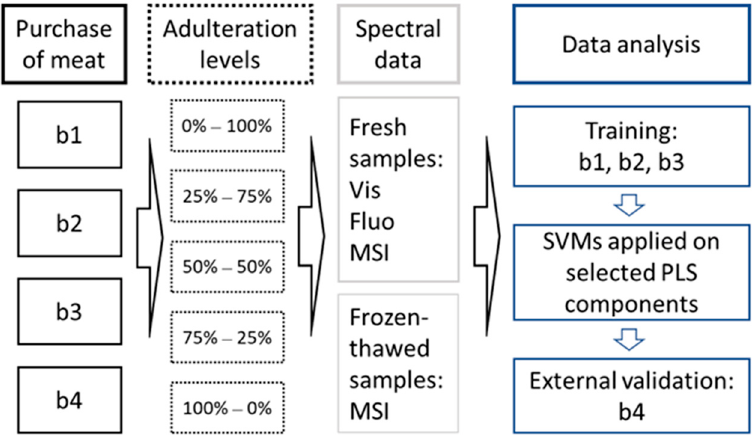
Figure 2. Experimental set up and data analysis for the two adulteration scenarios, i.e., pork with chicken (and vice versa) and beef with bovine offal. b: batch; Vis: visible spectra; Fluo: fluorescence signals; MSI: multispectral imaging; SVMs: support vector machines; PLS: partial least-squares.